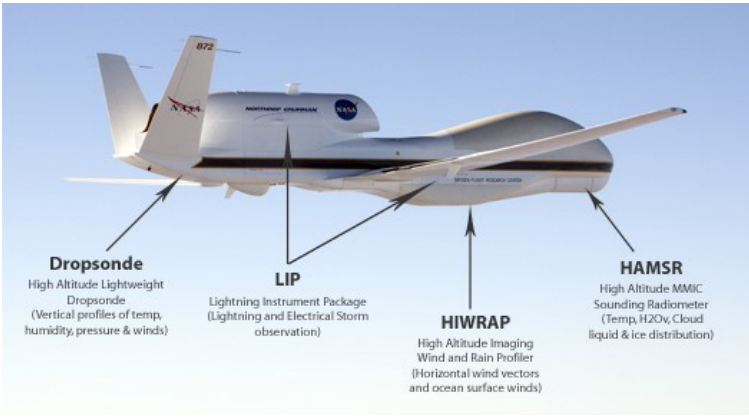
Figure 1. NASA’s Global Hawk platform and payload as configured for the GRIP mission (courtesy of NASA ESPO).